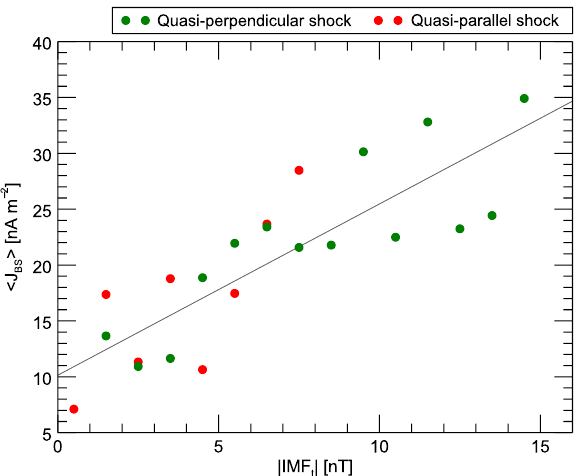
Figure 8. Current magnitude in dependence of the IMF tangential component. The IMF t component is calculated via the shock normal direction and is binned into intervals of 1nT. The current magnitude < J BS > is calculated by averaging over all quasi-perpendicular and all quasi-parallel current events that are ascribed to the corre- sponding